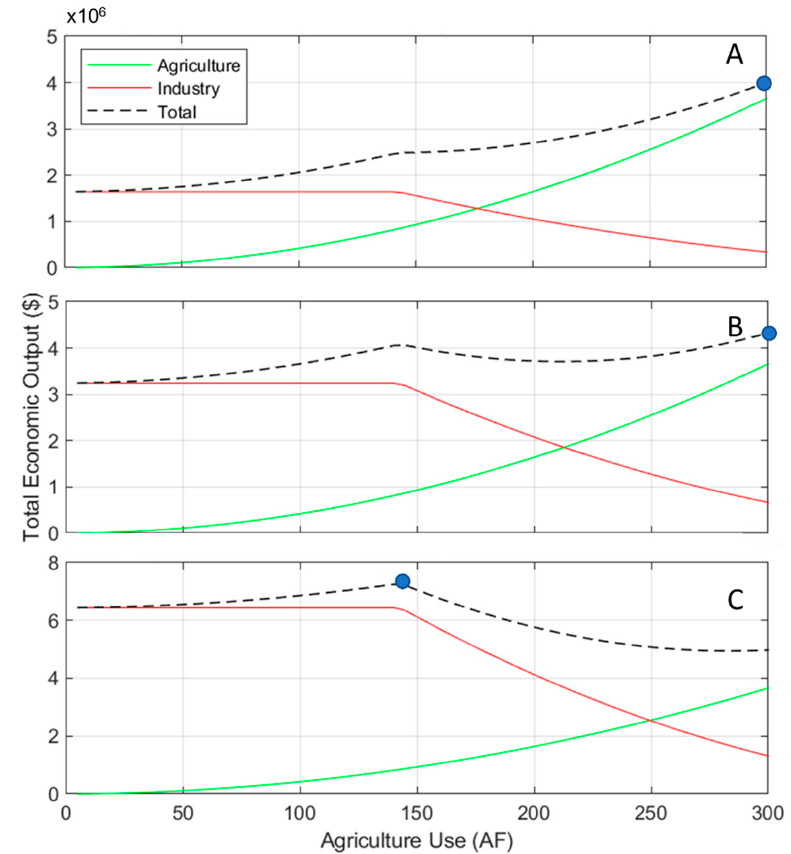
Figure 3. Comparison of optimal water allocation for 300 AF of total water, for WTP ratios of ( A ) 1:1, ( B ) 2:1, and ( C ) 4:1 between industrial and agricultural use. Maximum GRP (blue dots) is achieved for different allocations depending on relative WTP between the two sectors. Water available for industrial use is as in Figure